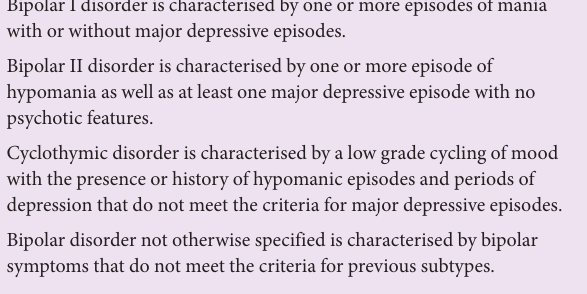
Table 1. Diagnostic and Statistical Manual of Mental Disorders, Fourth Edition, Text Revision (DSM-IV-TR) classification of bipolar subtypes